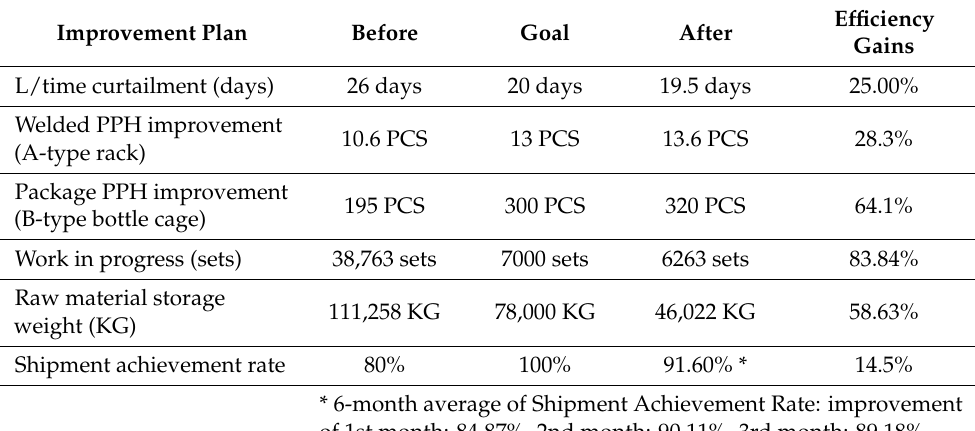
Figure 5. Map for the promotion of lean manufacturing mode in an SME. Table 15. Efficiency improvement statistics: before and after the improvement